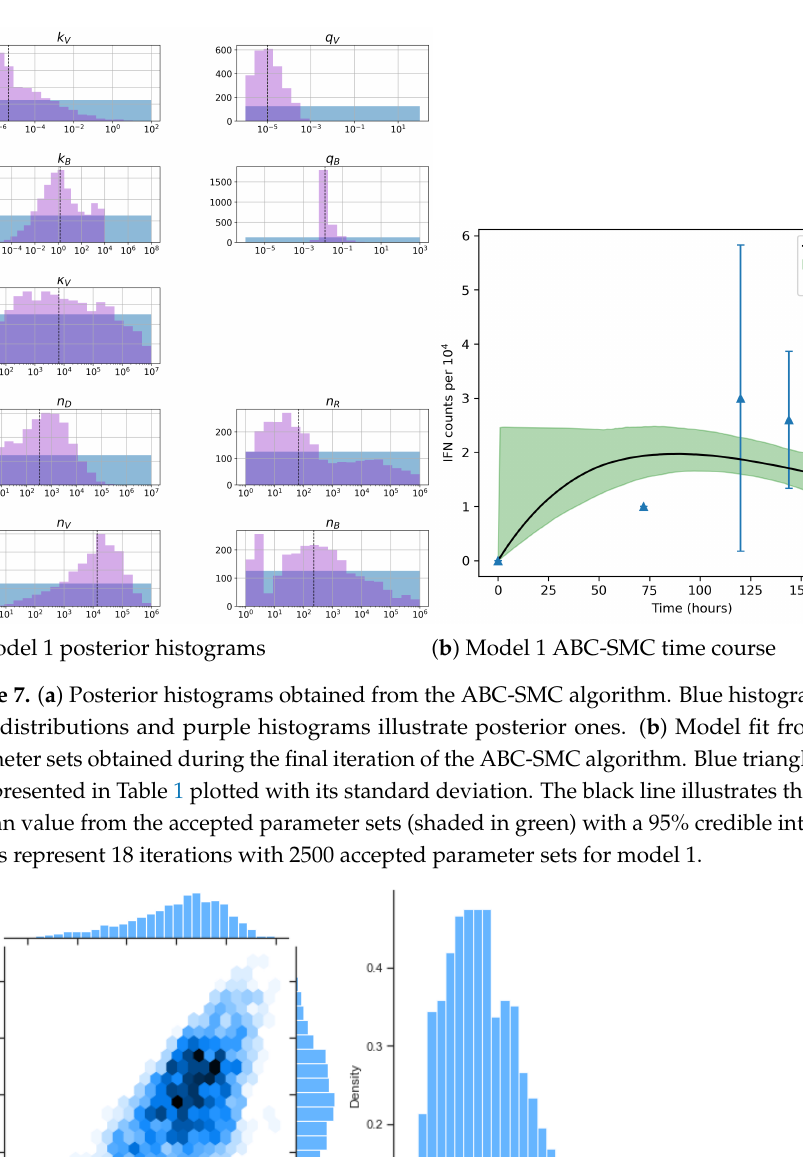
Figure 8. Left: bivariate posterior histogram of log tion ( r = 0.65). Right: posterior distribution for the ratio log ( n V / n D )